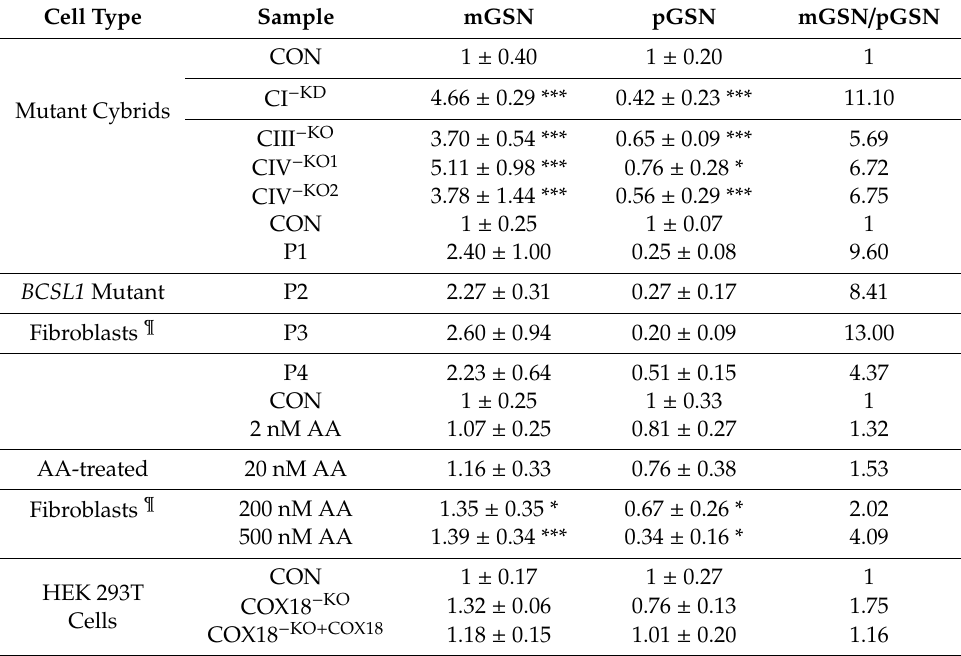
Table 3. Relative levels of mGSN and pGSN in human cultured